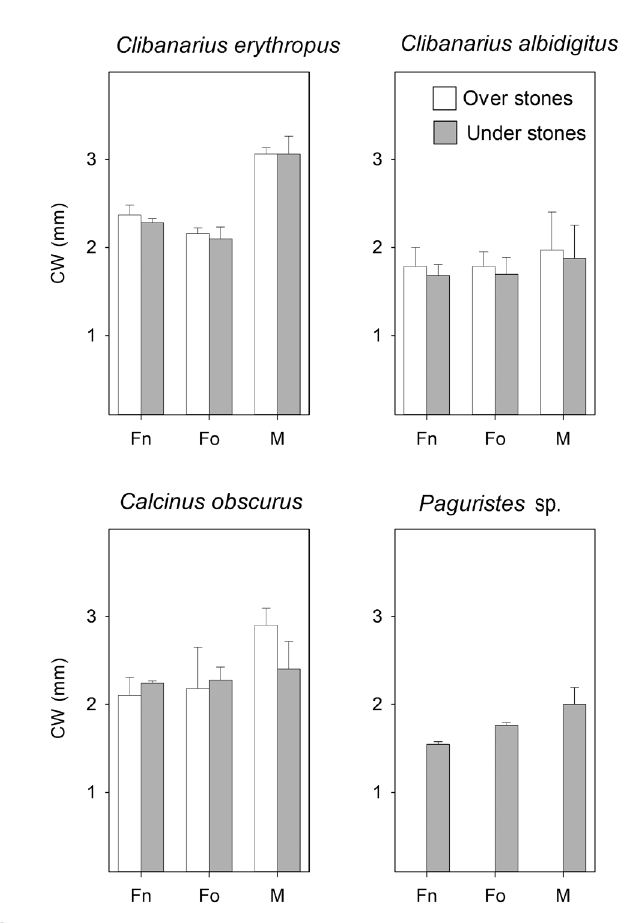
Figure 4. Number of non-ovigerous females (Fn), ovigerous females (Fo) and males (M) per hermit crab species, which were exhibiting air-exposure behavior on rocks (open bar) and those clustering under rocks (filled bar). Percentages indicate the proportion of air-exposure hermit crabs compared to those clustering under rocks.